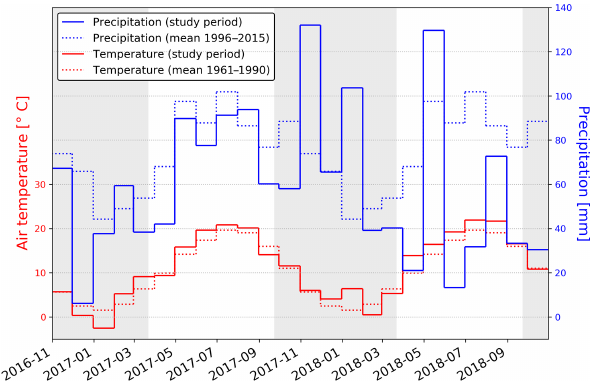
Figure 3. Layers of a typical permeable pavement built in accor- dance to national